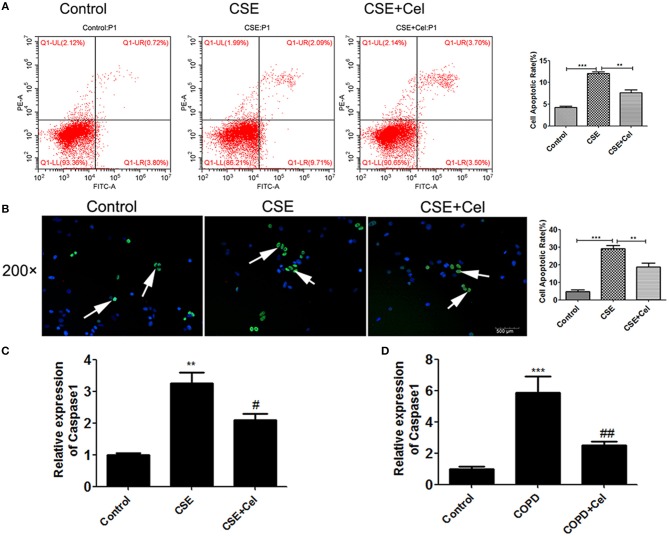
Effects of Celastrol on apoptosis. (A) Detection of apoptosis by flow cytometry. (B) Detection of apoptosis by TUNEL assay (× 200, scale bars = 500 μm). (C) mRNA expression of the apoptosis-related factor caspase-1 in cells. (D) mRNA expression of caspase-1 in mouse lung tissue. Each result was derived from three independent experiments. The condensed and fragmented nuclei are indicated with arrows. Values are expressed as the mean ± SEM (n = 3) **p < 0.01, p < 0.001 with respect to the control group; #p < 0.05, ##p < 0.01 with respect to the CSE group or COPD group.